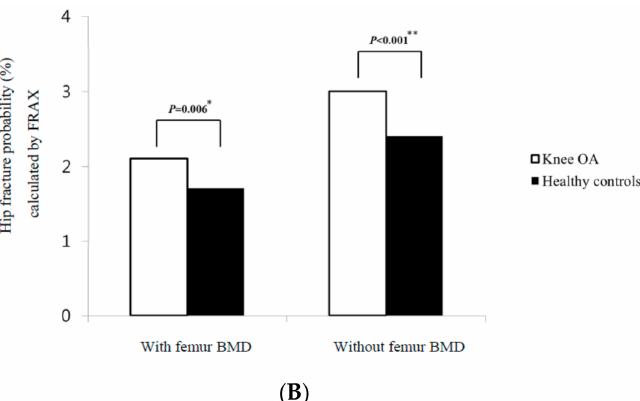
Figure 2. ( A ). Comparison of major osteoporotic fracture probabilities calculated by FRAX in the knee osteoarthritis and healthy controls. The results were expressed as mean ± SD. ( B ). Comparison of hip fracture probabilities calculated by FRAX in the knee osteoarthritis and healthy controls. The results were expressed as mean ± SD. * p < 0.05, ** p < 0.005, Statistical analysis was performed using paired t -test. FRAX,